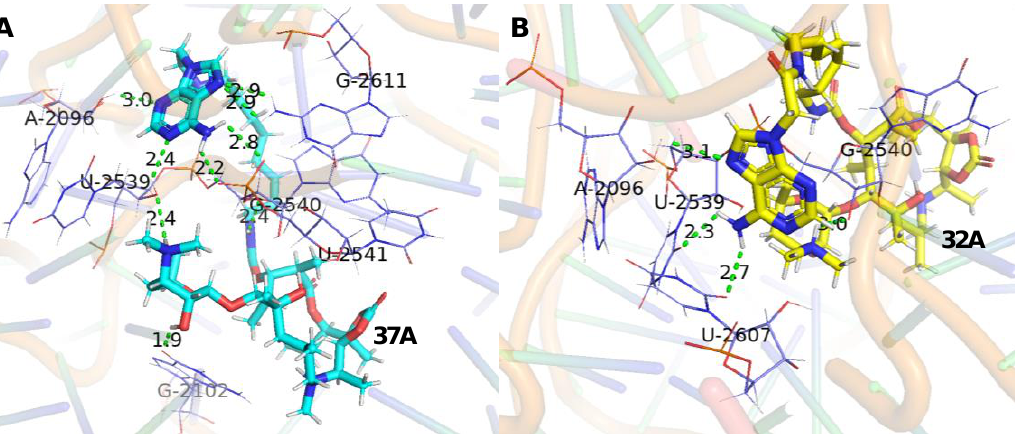
Figure 2. Interactions of the ligands with 50S ribosomal subunit (PDB ID: 1YHQ). ( A ). Interaction between 37A (cyan) and 50S ribosomal subunit. ( B ). Interaction between 32A (yellow) and 50S ribosomal subunit. The green dashed lines represent conventional hydrogen bonds. The labeled bases are colored purple and shown in licorice by PyMOL [38].